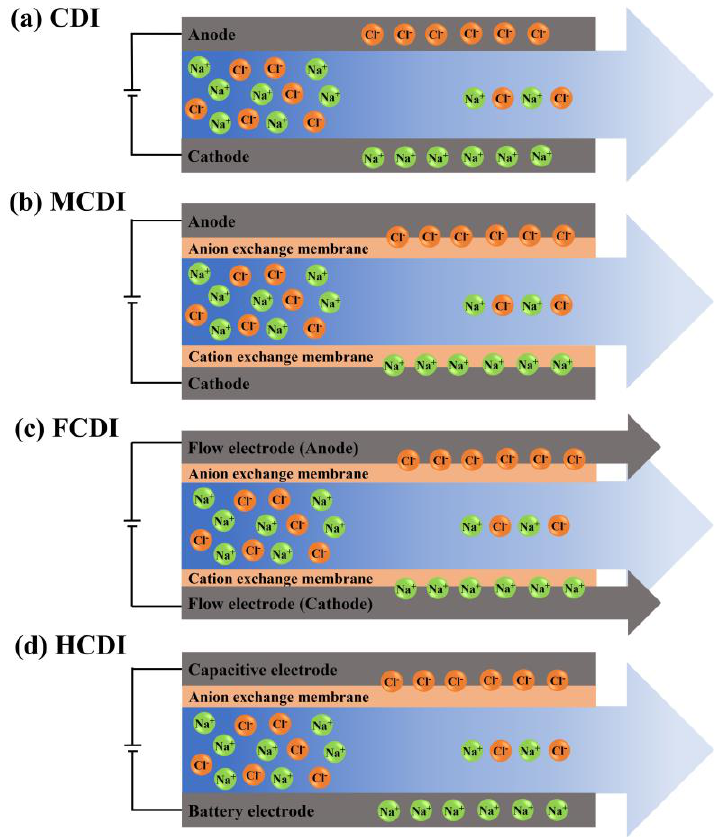
Figure 2. Architecture diagrams and removal mechanisms of ( a ) CDI, ( b ) MCDI, ( c ) FCDI, and ( d ) HCDI.